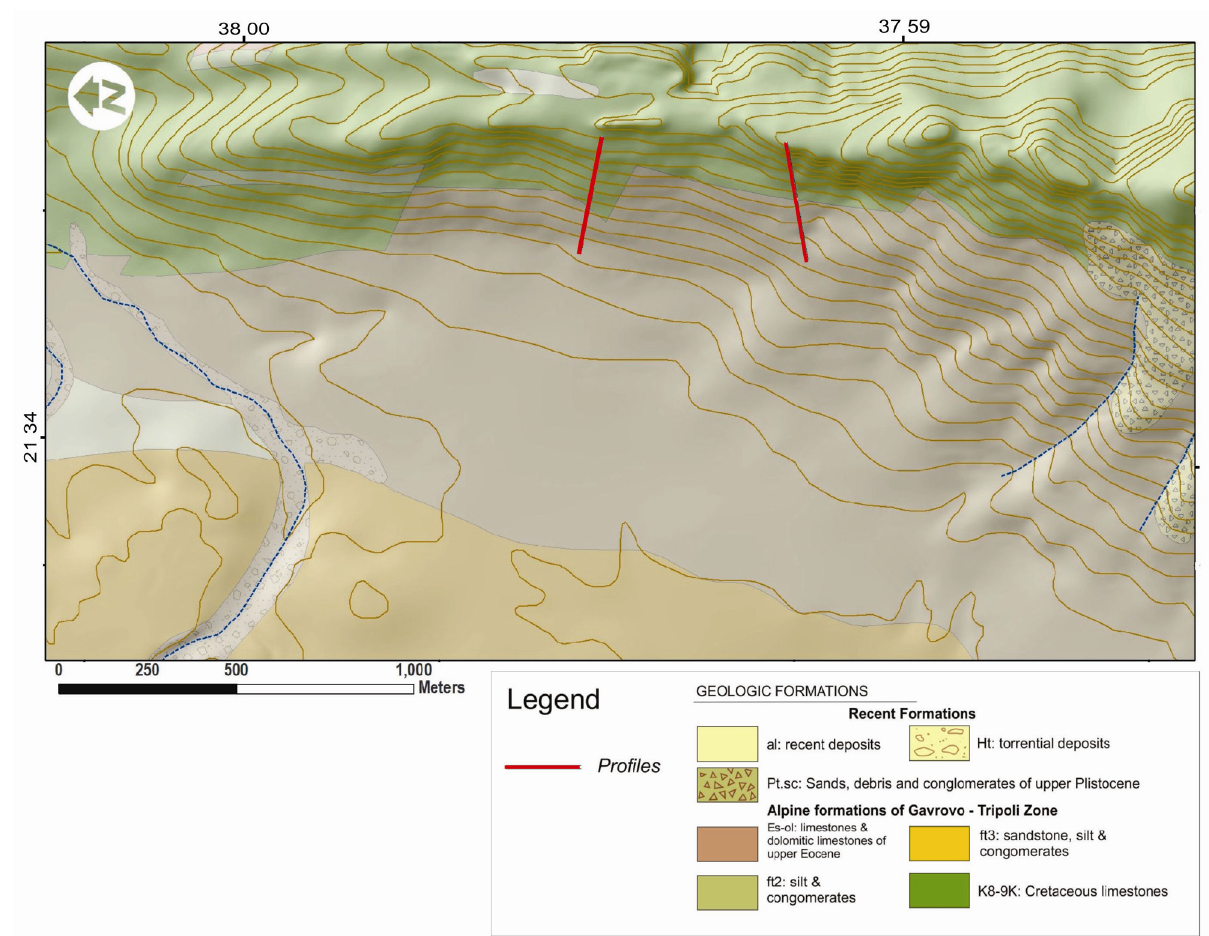
Figure 13. Geological map of the area of Skolis Mountain (contour lines: 20 m).